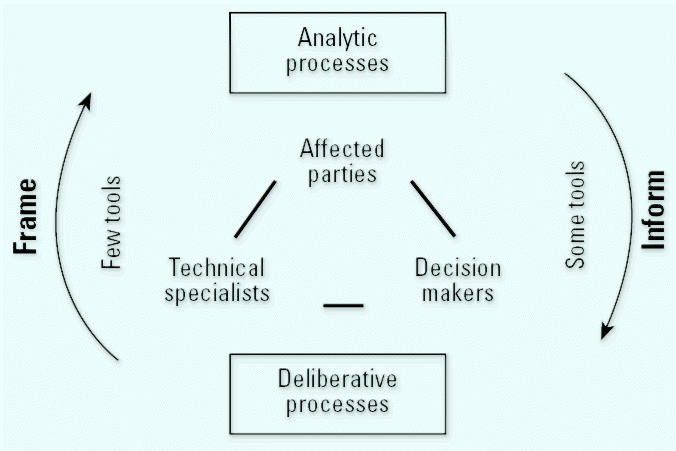
Model of the analytic–deliberative risk process adapted from Drew et al. (2003) and the National Research Council (1996).